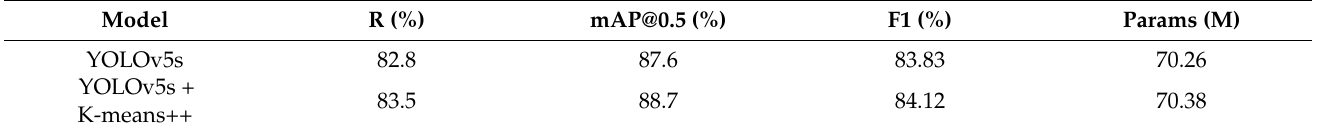
Table 5. Effect of K-means++ clustering algorithm on model detection